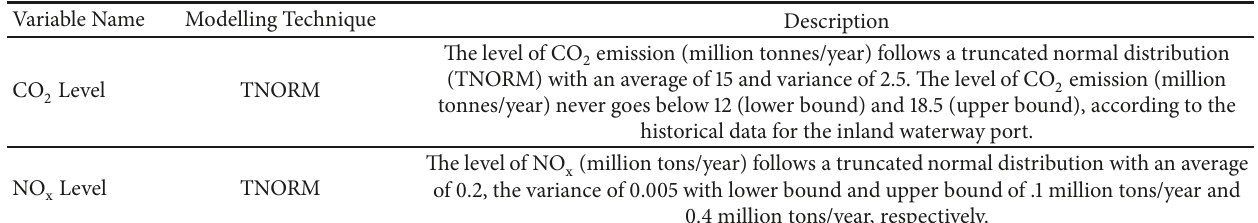
Table 10: Modelling of variables related to emission at the port.